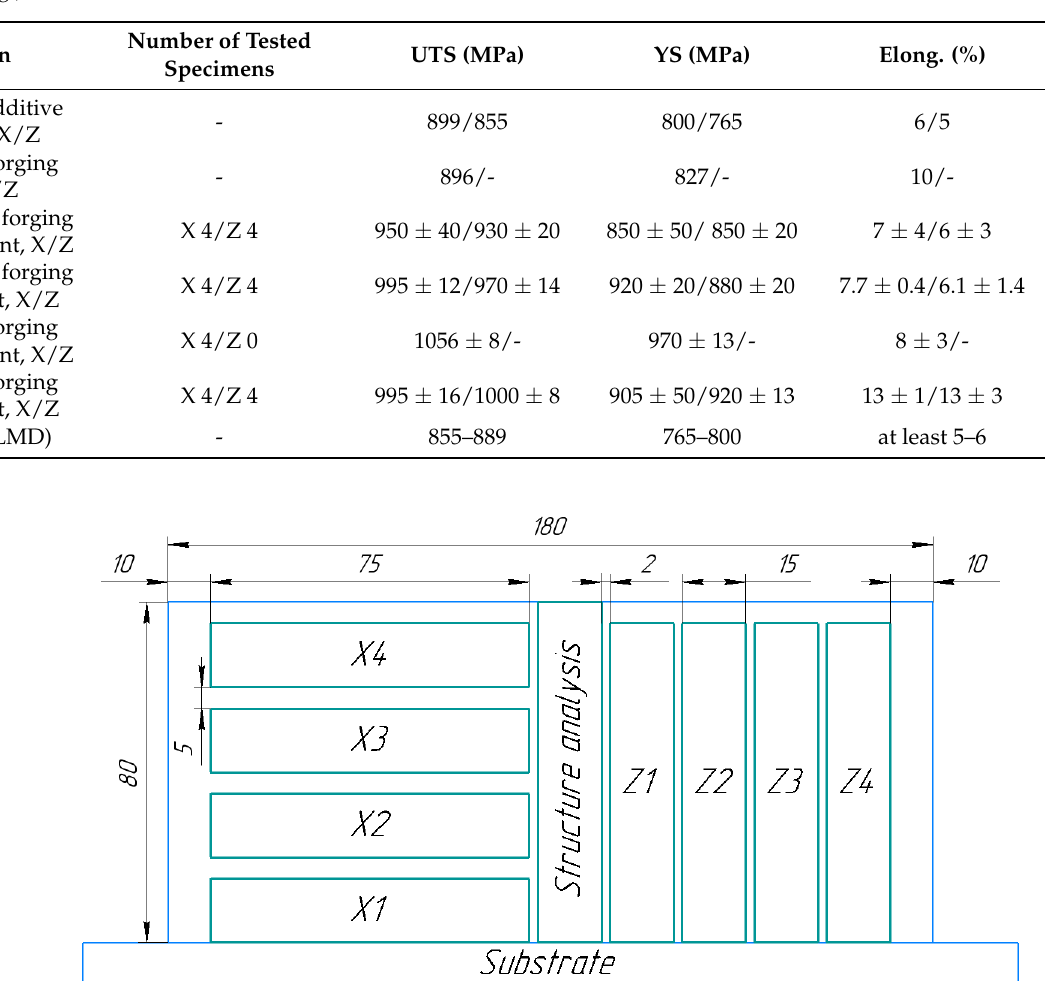
Table 3. Deposition modes and mechanical properties of specimens: ultimate tensile strengths (UTS), yield strengths (YS), and elongation (Elong.).